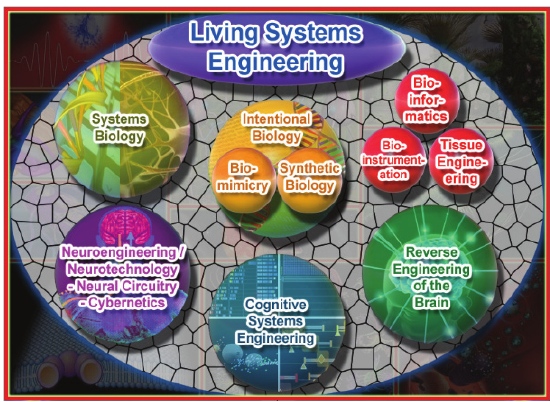
Figure 1. Components of Living Systems